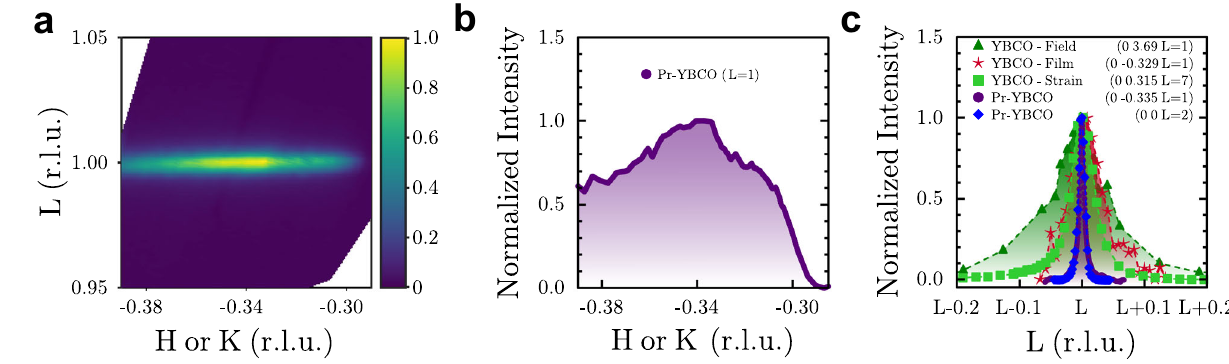
Fig. 2 | The reciprocal space structure of the 3D CO at T =50 K. a An HL or KL reciprocal space map collected at 932.4 eV shows a diffraction feature centered at (0-0.3351)reciprocallatticeunits(r.l.u.). b Acutalong HorK at L =1showsthepeak is centered around a value of H or K = -0.335 (r.l.u.). c A comparison of the out-of-